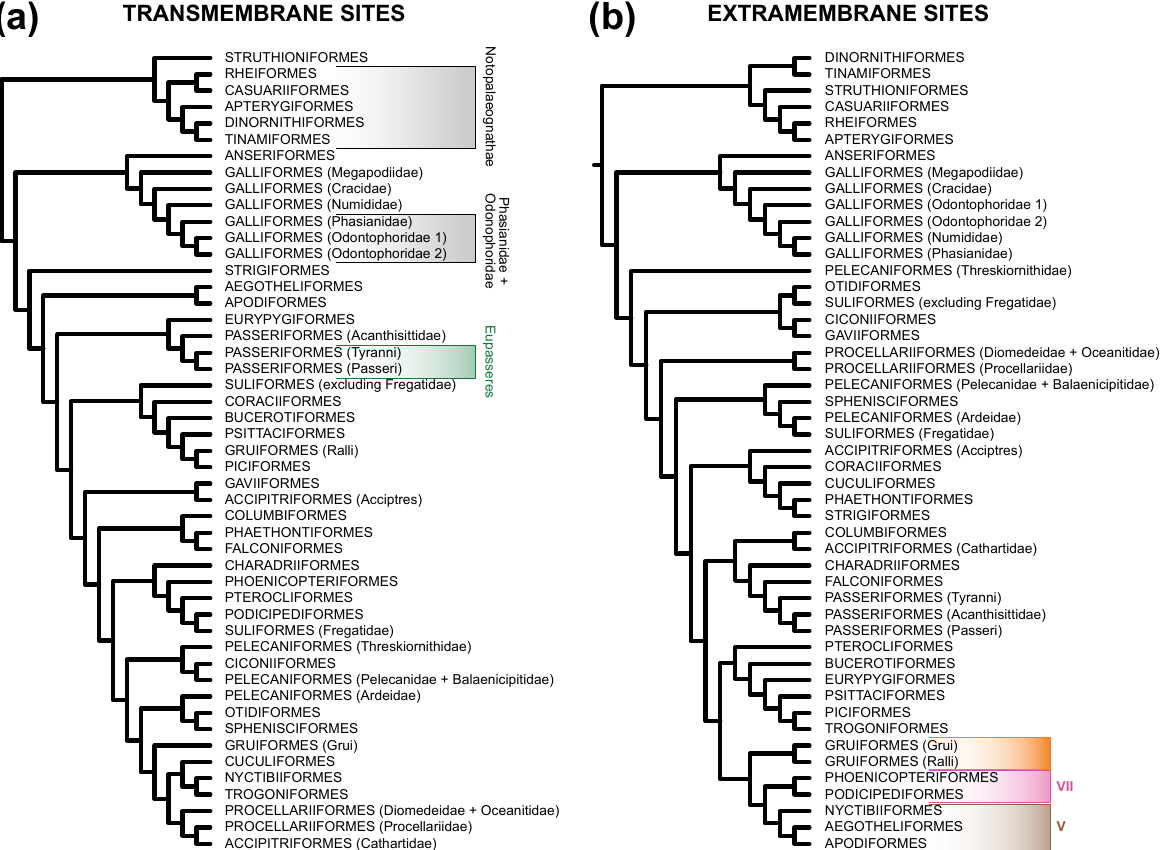
Figure 4. Condensed ML trees for 420 taxon mitochondrial data matrix estimated for each data type using the GTR 20 + I + Γ model. ( a ) Sites annotated as TM. ( b ) Sites annotated as ExM. Most tips reflect multiple taxa, with orders collapsed to yield a single tip whenever they were monophyletic. Cases where taxa in the same order were not recovered as monophyletic in at least one of the analyses (e.g., Accipitriformes, Suliformes, and Gruiformes) are presented as two or more tips with information regarding the subset of the order that the tip represents in parentheses. Boxes to the right of each tree indicate clades highlighted in the results. Complete trees with branch lengths and ultrafast bootstrap support for all branches are available as a Nexus format treefile in Supplementary File S3.